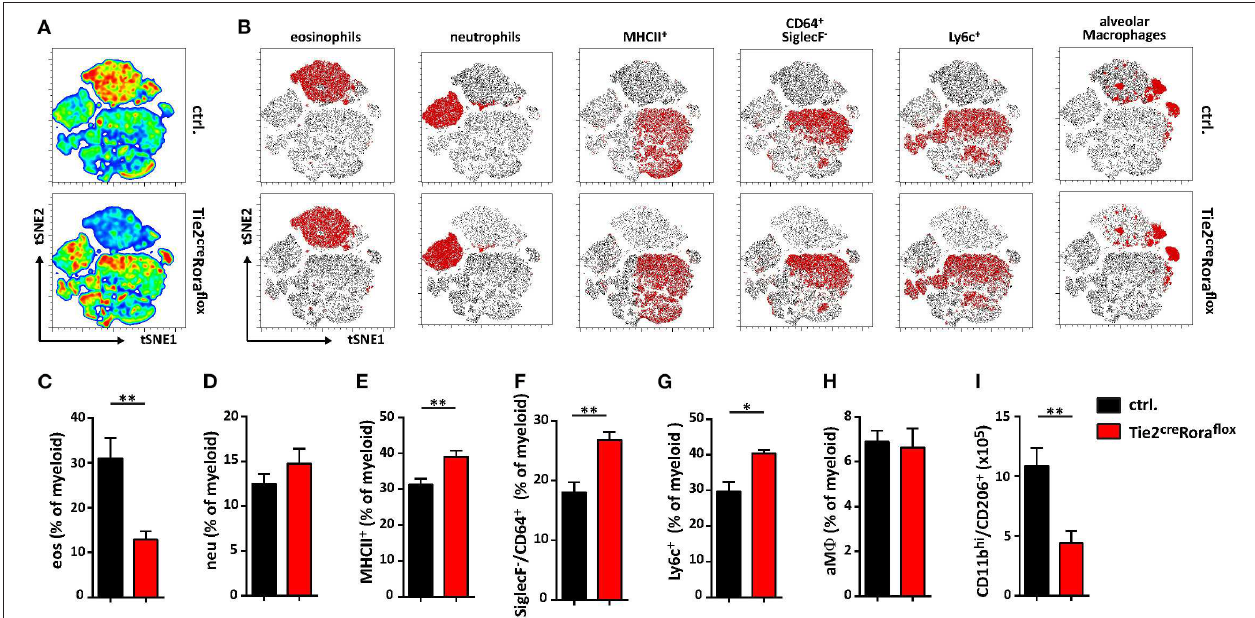
FIGURE 5 | Altered polarization patterns in the myeloid compartment in the absence of ILC2 mice. (A–I) Control and Tie2 cre Rora flox mice were challenged intranasally with 500 cfu of C. neoformans and sacrificed 14 dpi. (A) t-SNE plots of flow cytometric analyzed pulmonary myeloid cell composition (t-SNE 1/t-SNE 2 represents individual marker expression of CD11b, CD11c, CD64, Ly6c, Ly6g, MHCII, and SiglecF of individual data points) in control and Tie2 cre Rora flox mice. Color code depicted is reflecting relative cell density (blue = low, red = high; n = 8/genotype). (B) Representative t-SNE-maps of control and Tie2 cre Rora flox mice show localization of respective surface marker positive cell clusters (red area) within t-SNE plots ( n = 8). (C–I) Relative abundance of (C) CD11b + /CD64 − /Ly6g − /SiglecF + eosinophil Granulocytes (eos), (D) CD11b + /Ly6g + /Ly6c + neutrophil Granulocytes (neu), (E) SiglecF − /MHCII + cells, (F) SiglecF − /CD64 + , (G) SiglecF − /Ly6c + and (H) CD11b int / + /CD11c int / + /CD64 + /SiglecF + alveolar macrophages (aM φ ) referred to total myeloid cells in control (ctrl. n = 8) and Tie2 cre Rora flox ( n = 7) mice. (I) Quantification of CD11b hi /CD206 + cells in total lung tissue of infected animals (ctrl. n = 4; Tie2 cre Rora flox mice n = 6). (A,B) t-SNE analysis and (C–I) flow cytometry shown is representative for two individual experiments. (C,I) Data is expressed as mean ± SEM. * P ≤ 0.05; ** P ≤ 0.01 defined by Mann-Whitney U